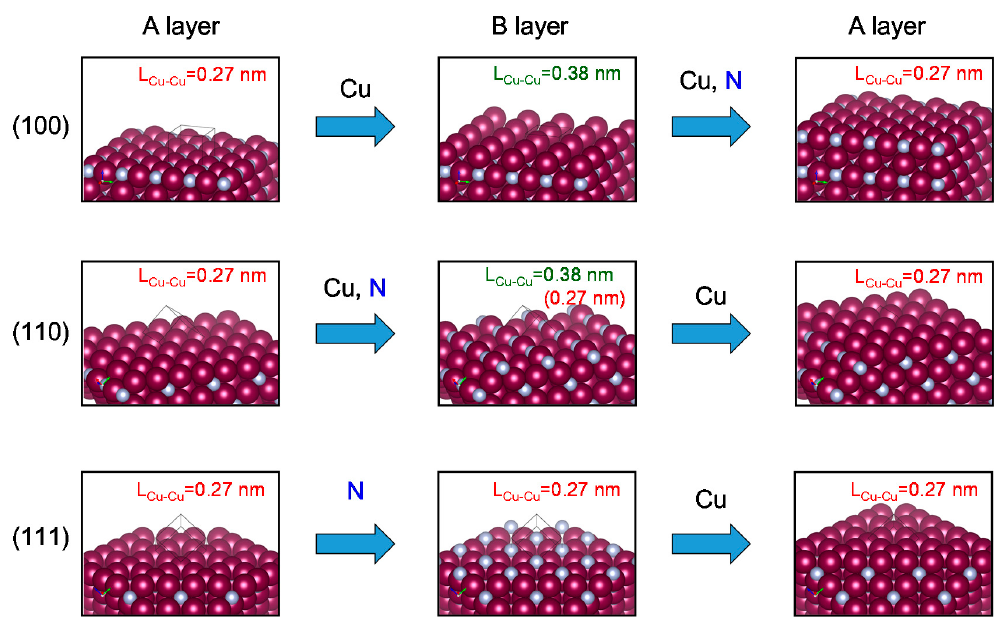
Figure 7. Images of atomic arrays on the (100), (110) and (111) surfaces of copper nitride and elements that form the next crystal layer.